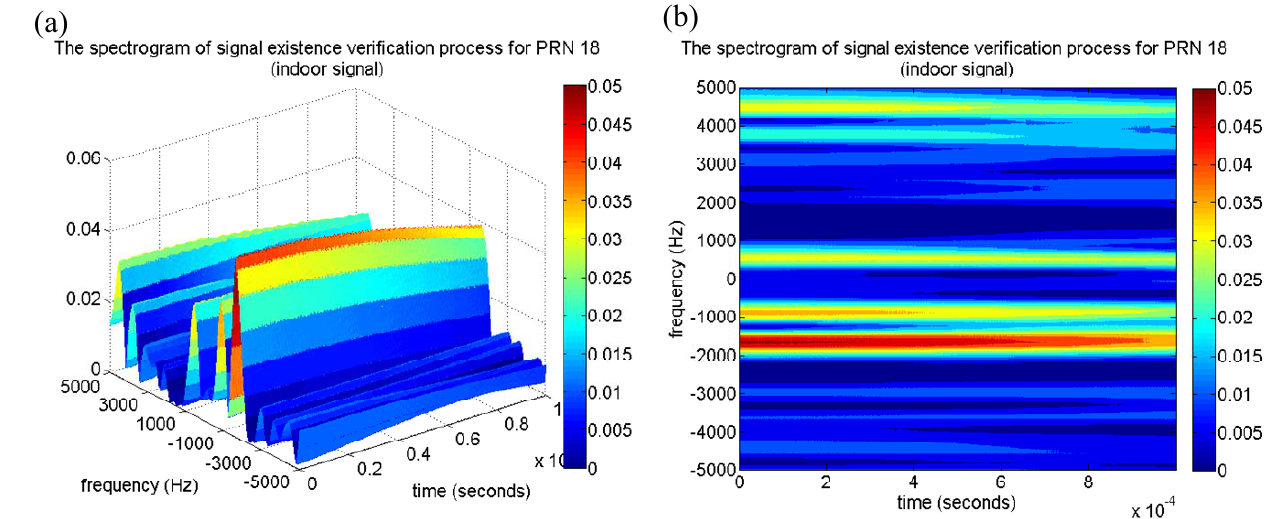
Figure 11. (a) The spectrogram of the proposed approach for PRN 18 satellite signal. (b) The top view of (a), a characteristic sinusoid wave can be observed around the frequency of − 1,500 Hz.